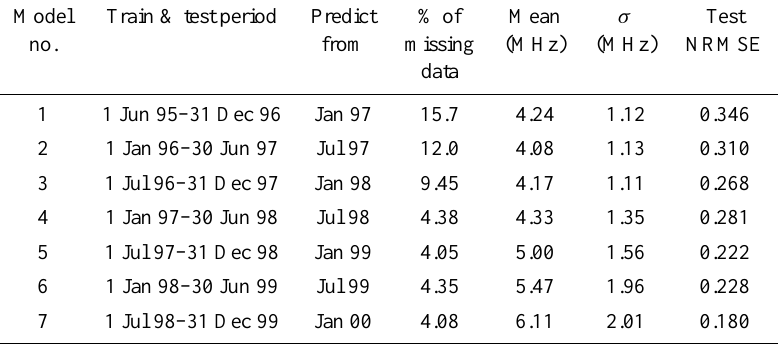
Table 1. Description of prediction models Model Train & test period Predict % of Mean σ Test no. from missing (MHz) (MHz) NRMSE data